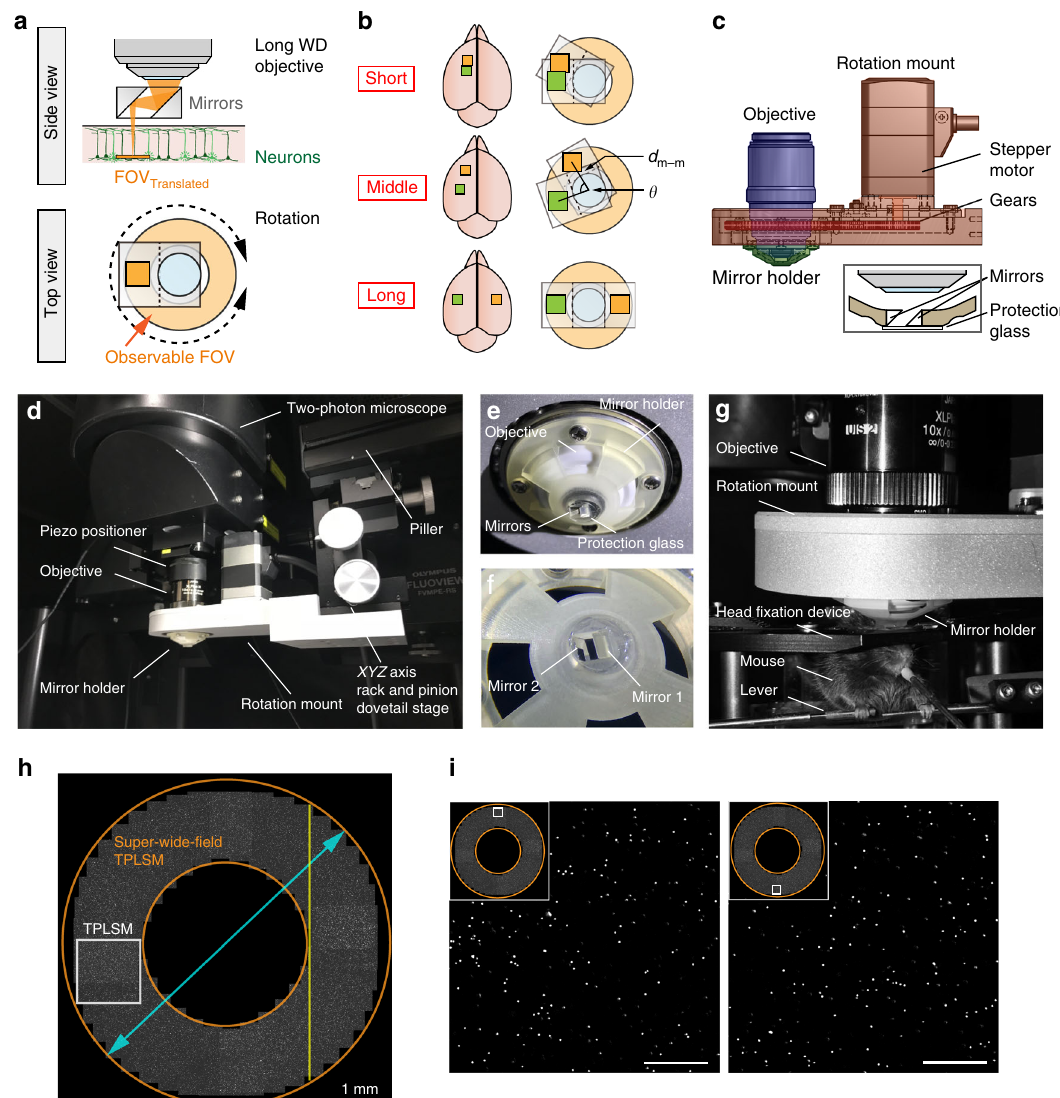
Fig. 1 Design of the super-wide- fi eld TPLSM. a Schema of the super-wide- fi eld TPLSM. The excitation beam emitted from the objective is translated by a pair of mirrors. The orange donut shape (lower panel) represents the FOV observable by mirror rotation. b Left, schema for imaging of two distant areas in the mouse neocortex. Right, the distance between the two imaged areas (short, middle, and long) in the left image is determined by the inter-mirror distance ( d m – m ) and the rotation angle ( θ ). c Side view of the mirror holder with a pair of mirrors (green), a motorized rotation mount with three gears (red), and an objective (blue). The inset shows the median section of the mirror holder. d Photograph of the super-wide- fi eld TPLSM. The holder with the mirrors is attached to the rotation mount and installed under a water-immersion objective connected to a two-photon microscope. The mount is supported by the pillar, independent of the microscope. The center position of the device is adjusted to fi t with the optical axis of the objective using an XYZ -axis rack and pinion dovetail stage placed between the mount and the pillar. e , f Photograph of the holder with the mirrors. Mirrors 1 and 2 are the mirrors in the entering and exiting sides, respectively. g Photograph of the system for in vivo imaging of a behaving mouse. The mirror holder was set between the imaging window of the animal and the objective. The device occupied only the space above the head; therefore, there was suf fi cient space to place a head fi xation device. h Measurement of the FOV observable by driving the micro-opto-mechanical device, and demonstrated by a stitched two-photon image of agarose-embedded fl uorescent microbeads (2 µ m). The white square represents a single FOV. The orange donut shape demonstrates the FOV observable by driving the micro-opto-mechanical device. The cyan arrow indicates the longest distance between the edges of the two observable FOVs. The yellow line indicates the longest line of stitch imaging. i Enlarged views of fl uorescent microbeads located in two regions (regions are shown in the upper left insets) 6 mm apart. Scale bar, 100 µ